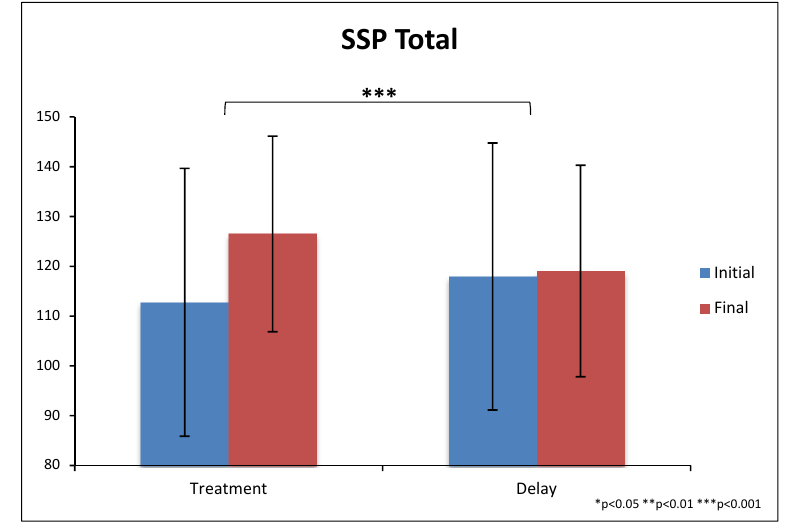
Figure 12. SSP scores at the beginning and end of the study. Note that higher scores represent fewer sensory problems. Error bars represent standard deviations.